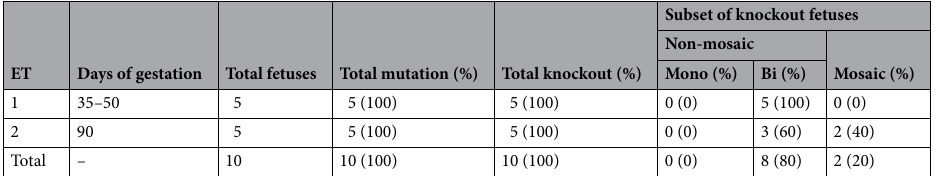
Table 2. Fetal genotypes at the target lincRNA#1 locus from embryo transfers (ETs) of zygotes injected 6 h post insemination with Cas9 protein and gRNAs linc 5 ′ g1 and linc 3 ′ g1. A fetus was considered mutated if a mutation was found at one or both gRNA target sites. Knockout rates are further classified in subsets of monoallelic (mono), biallelic (bi) and mosaic. Regarding ET1 where fetal demise occurred, days of gestation refers to how far along the fetuses were in development before they expired, not the days in which they were harvested.